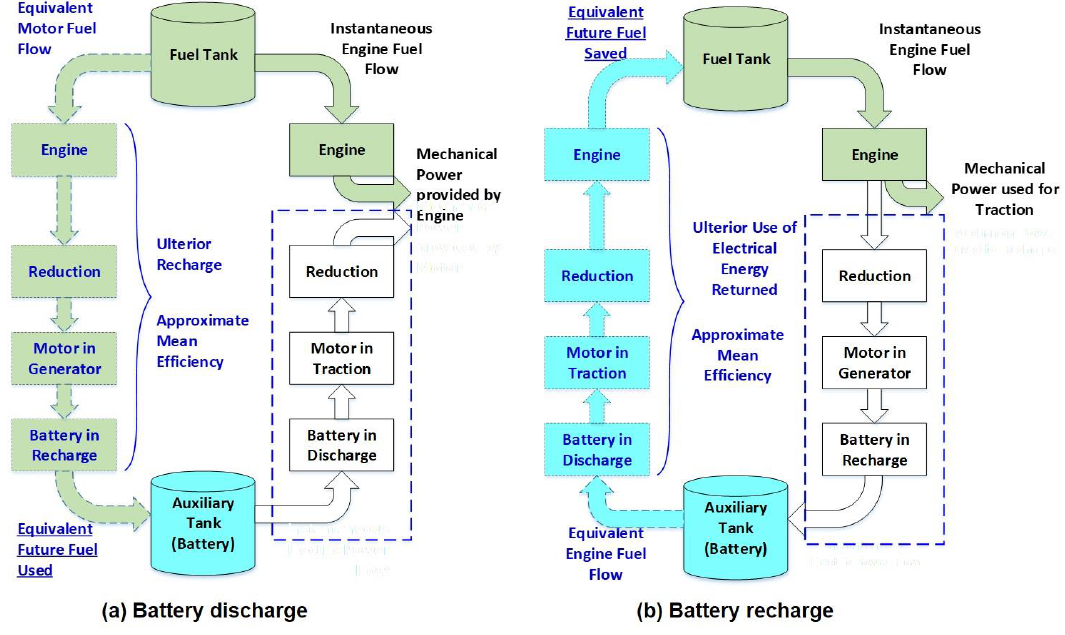
Figure 5. Energy flow diagram of a PHEV during ( a ) Battery charging and ( b ) Battery recharging through engine [26].